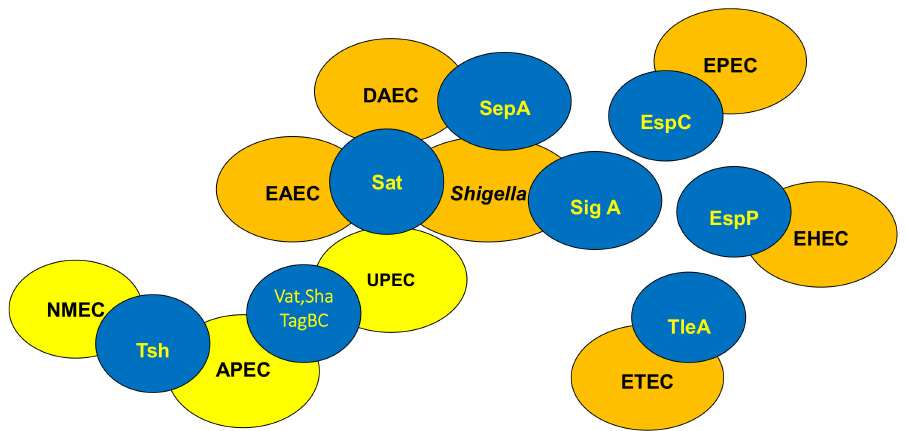
Figure 3. Distribution of SPATEs among intestinal and extra-intestinal pathogenic E. coli. SPATEs have been found not only in all recognized intestinal E. coli pathotypes (highlighted in orange) but also in extra-intestinal E. coli pathotypes (highlighted in yellow). The recent availability of many more bacterial genome sequences, has led to identification of new and previously described SPATE proteins among both human and animal pathogens, including Salmonella , Citrobacter , and Edwarsiella , as well as some commensal E. coli strains. (APEC, Avian pathogenic E. coli ; DAEC, Di ff use Adhering E. coli